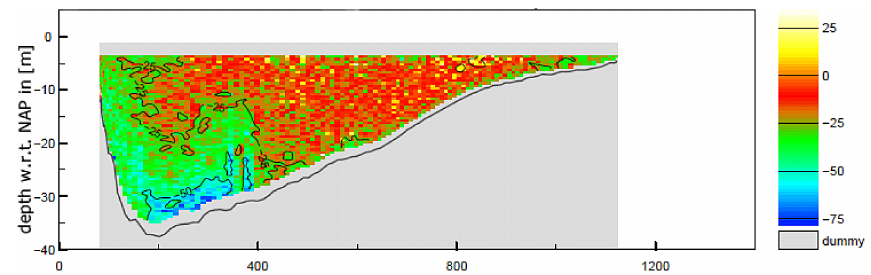
Figure 13. Observed current velocity in cms − 1 in cross section of the “Pas van Terneuzen” near buoy 18 on 6 July 2011 at 16:04LT. Positive velocity values indicate an ebb current and negative values indicate a flood current. At the bottom the flow has recently reversed, while on the surface the tide is still slacking. This illustrates the variability of the water current within a cross section of the estuary (courtesy of